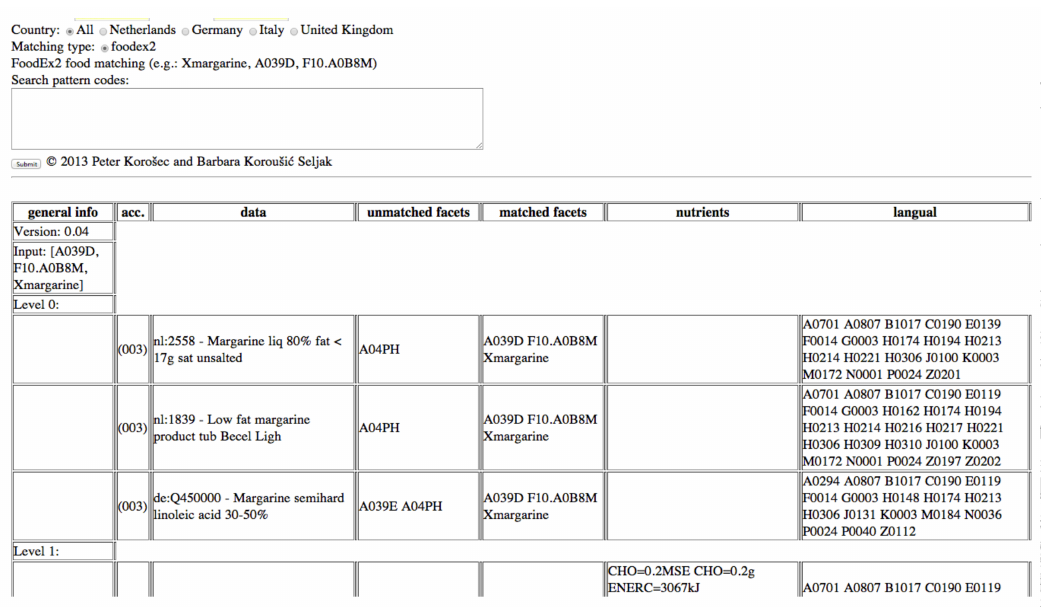
Figure 4. FoodEx2 to LanguaL food